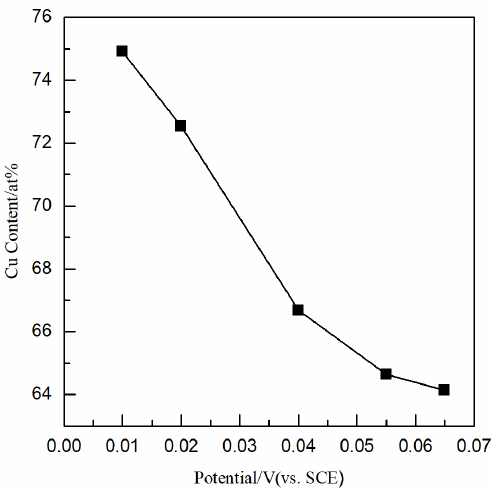
Figure 7. Variation of copper contents in Cu-Se film with deposition potentials.